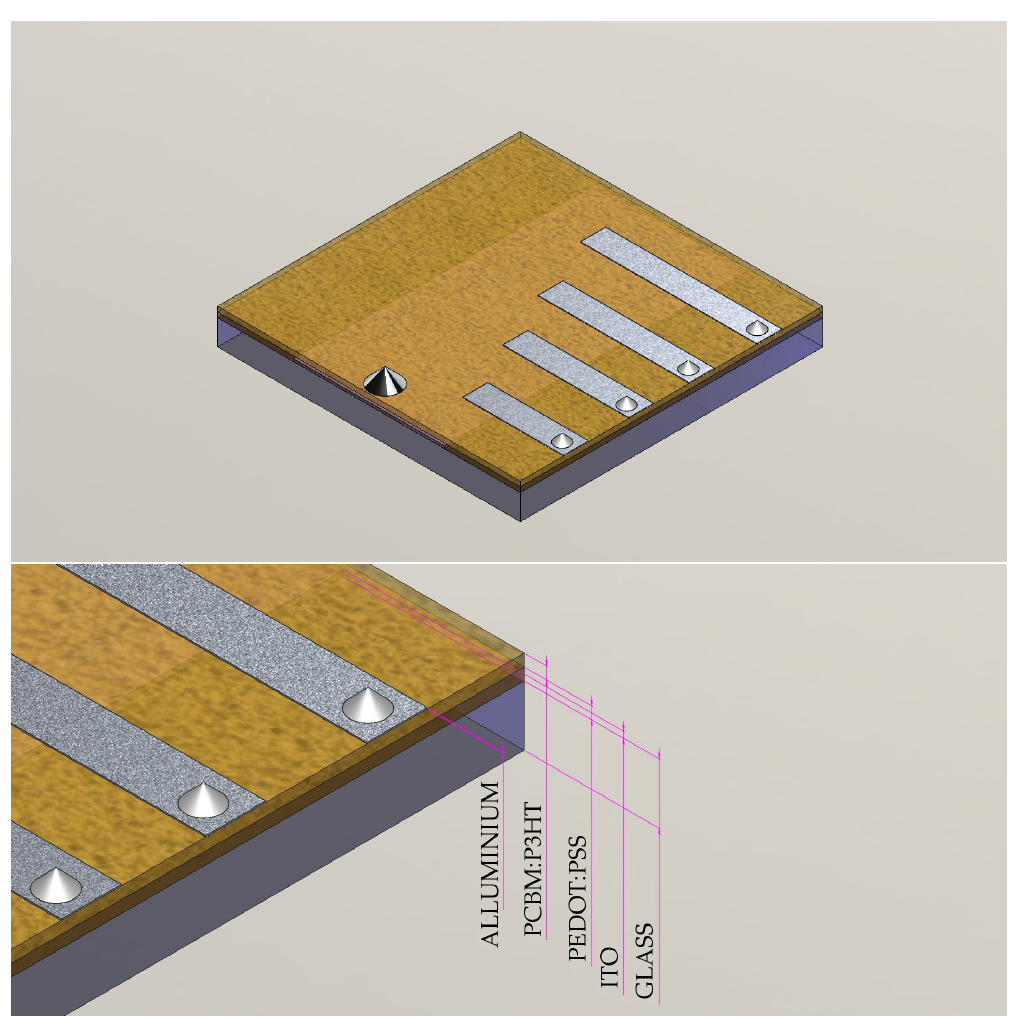
Figure 2. A representation of the geometry of a device containing four OSCs. On the bottom panel, a detail of the layers composition of the OSCs.